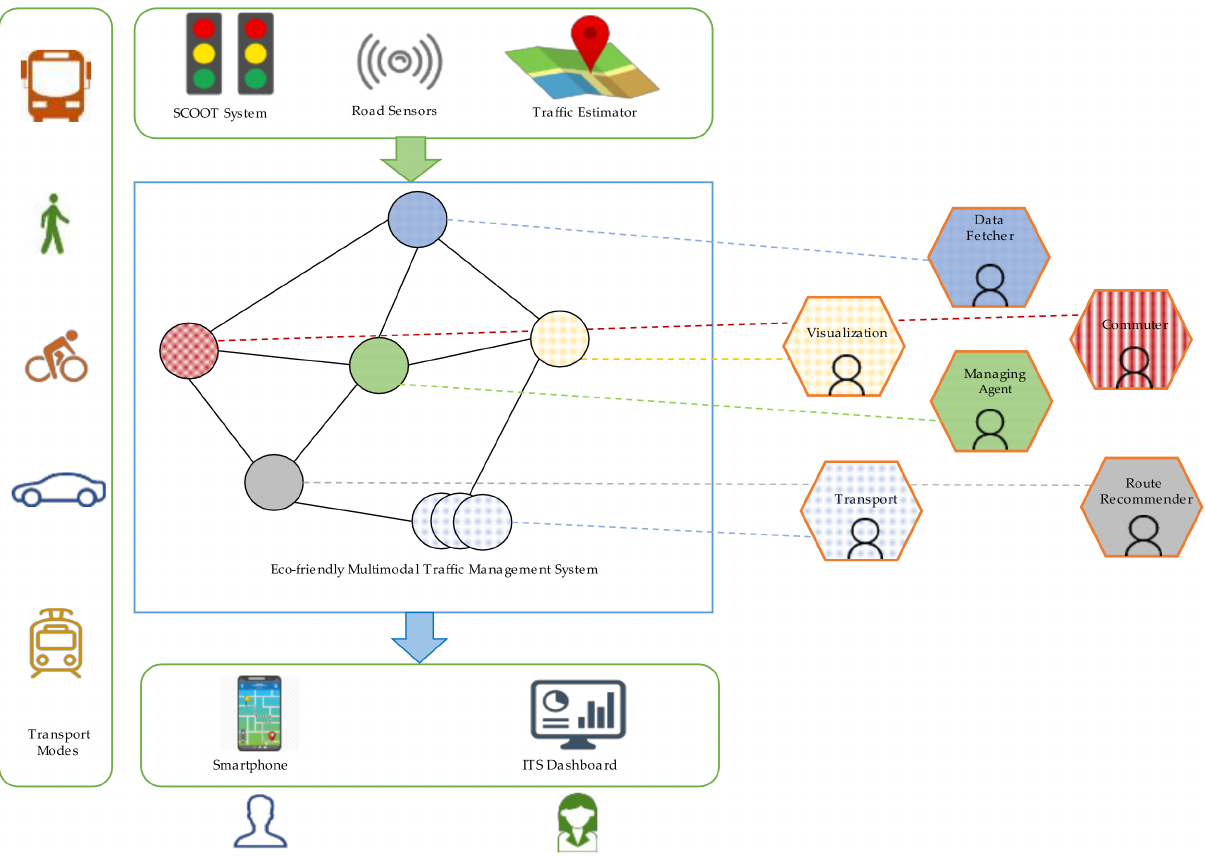
Figure 2. The eco-friendly multimodal route guidance architecture using multi-agent